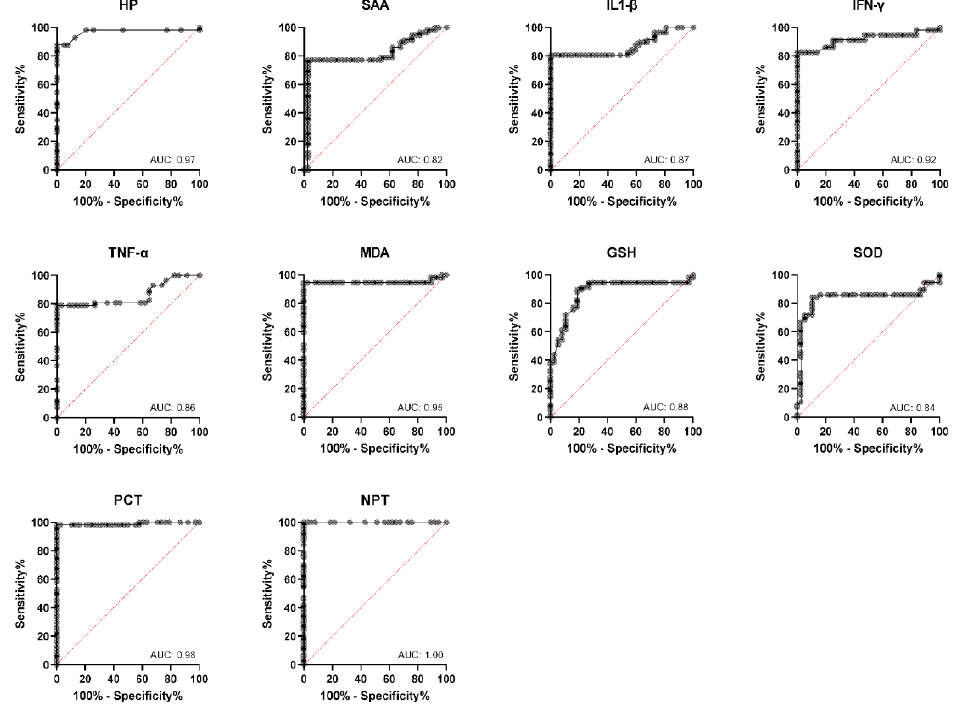
Figure 6. Receiver operating characteristic (ROC) curves for 10 selected blood biomarkers in diarrheic calves naturally infected with C. parvum pre- and 7 days post-treatment.